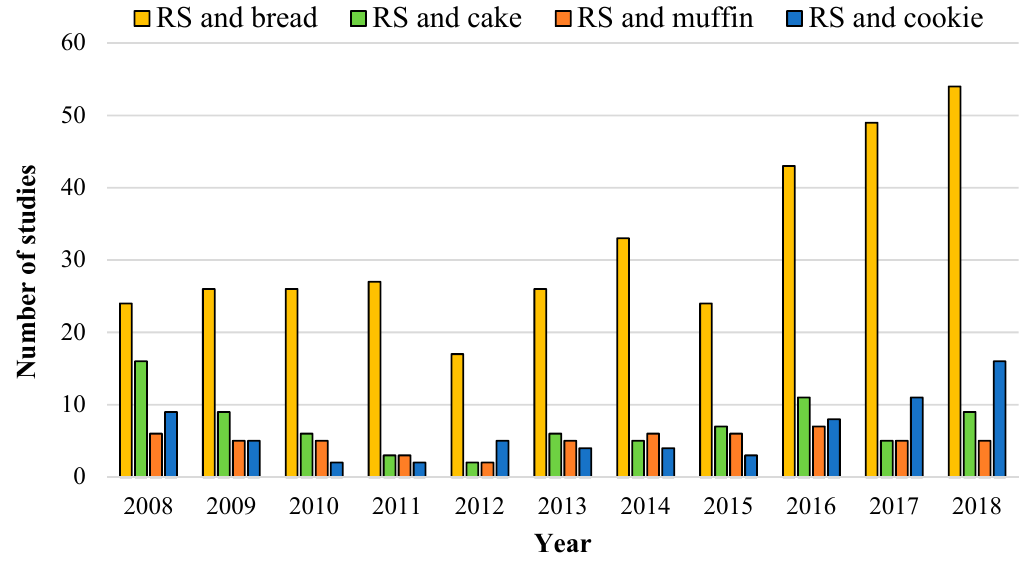
Figure 1. Literature search of the last 10 years on the topics: “resistant starch (RS) and bread”; “resistant starch and cake”; “resistant starch and muffin"; and “resistant starch and cookie”. Data collected from all databases from the Web of Science on 28 June 2019.